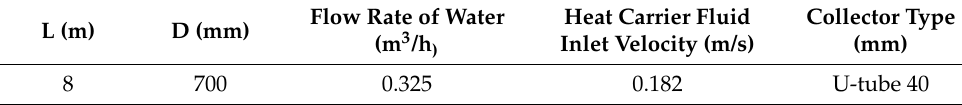
Figure 3. CPT test result: ( a ) Cone resistance, q c ; ( b ) Sleeve friction, f s [46]. Table 1. Physical properties and geometry of pile and GSHPs.